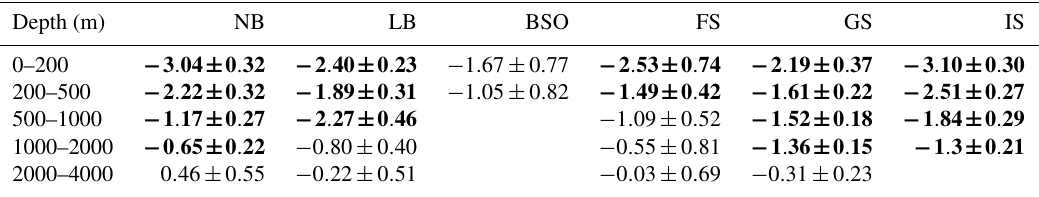
Figure 5. Maps of surface water (0m) pH and (cid:127) Ar for the preindustrial (PI) era (1850–1859), the present day (1996–2005), and the change between the two periods. The maps were calculated from the GLODAPv2 gridded climatologies (Lauvset et al., 2016), applying the simulated changes by the emission-driven NorESM1-ME, as explained in Sect. 4.2. Note that the increase in atmospheric CO 2 in NorESM1-ME is 13% higher than the observed record between 1850 and 2005, resulting in simulated a decrease in surface pH that is approximately 0.01 too strong (see Sect. 3.3). The dotted red line in panel (a) shows the location of the cross section presented in Fig. 6. Table 4. pH trends ± standard error (10 − 3 yr − 1 ) calculated from the data presented in Fig. 7 in the Norwegian Basin (NB), Lofoten Basin (LB), Barents Sea Opening (BSO), Fram Strait (FS), Greenland Sea (GS), and Iceland Sea (IS; Fig. 1). Bold numbers indicate that the trends are significantly different from zero. Depth (m) NB LB